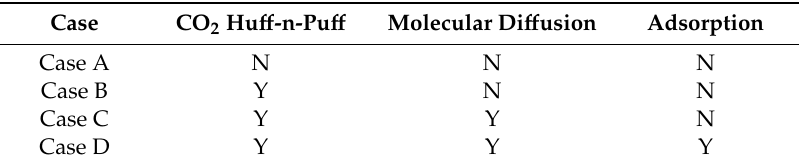
Table 2. Physical mechanisms in different cases.